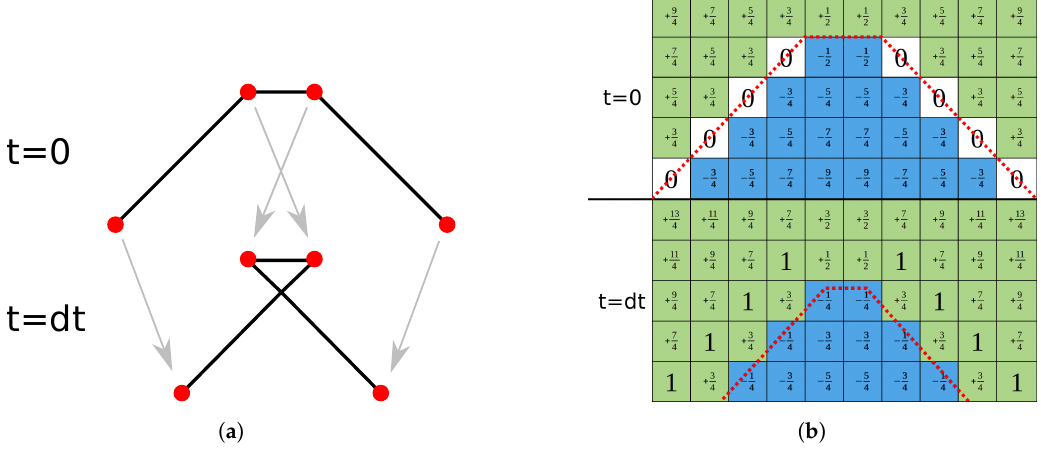
Figure 2. Schematic comparison between explicit and implicit surfaces being moved, highlighting self-intersection in explicit surfaces. In contrast, the level set method applied in ( b ) shows surface movement without self-intersection, albeit losing some features such as the expected sharp peak in the center of the geometry. ( a ) Nodes of an explicit surface moved by a velocity field, creating a self-intersection. Additional steps are required to form a correct representation of the surface. ( b ) Implicit surface being moved by adding unity to all values stored on a regular grid. The numbers represent the level set value stored at the center of each cell. Negative regions inside the surface are highlighted in blue, regions outside with positive values in green. Dashed, red lines indicate the explicit location of the